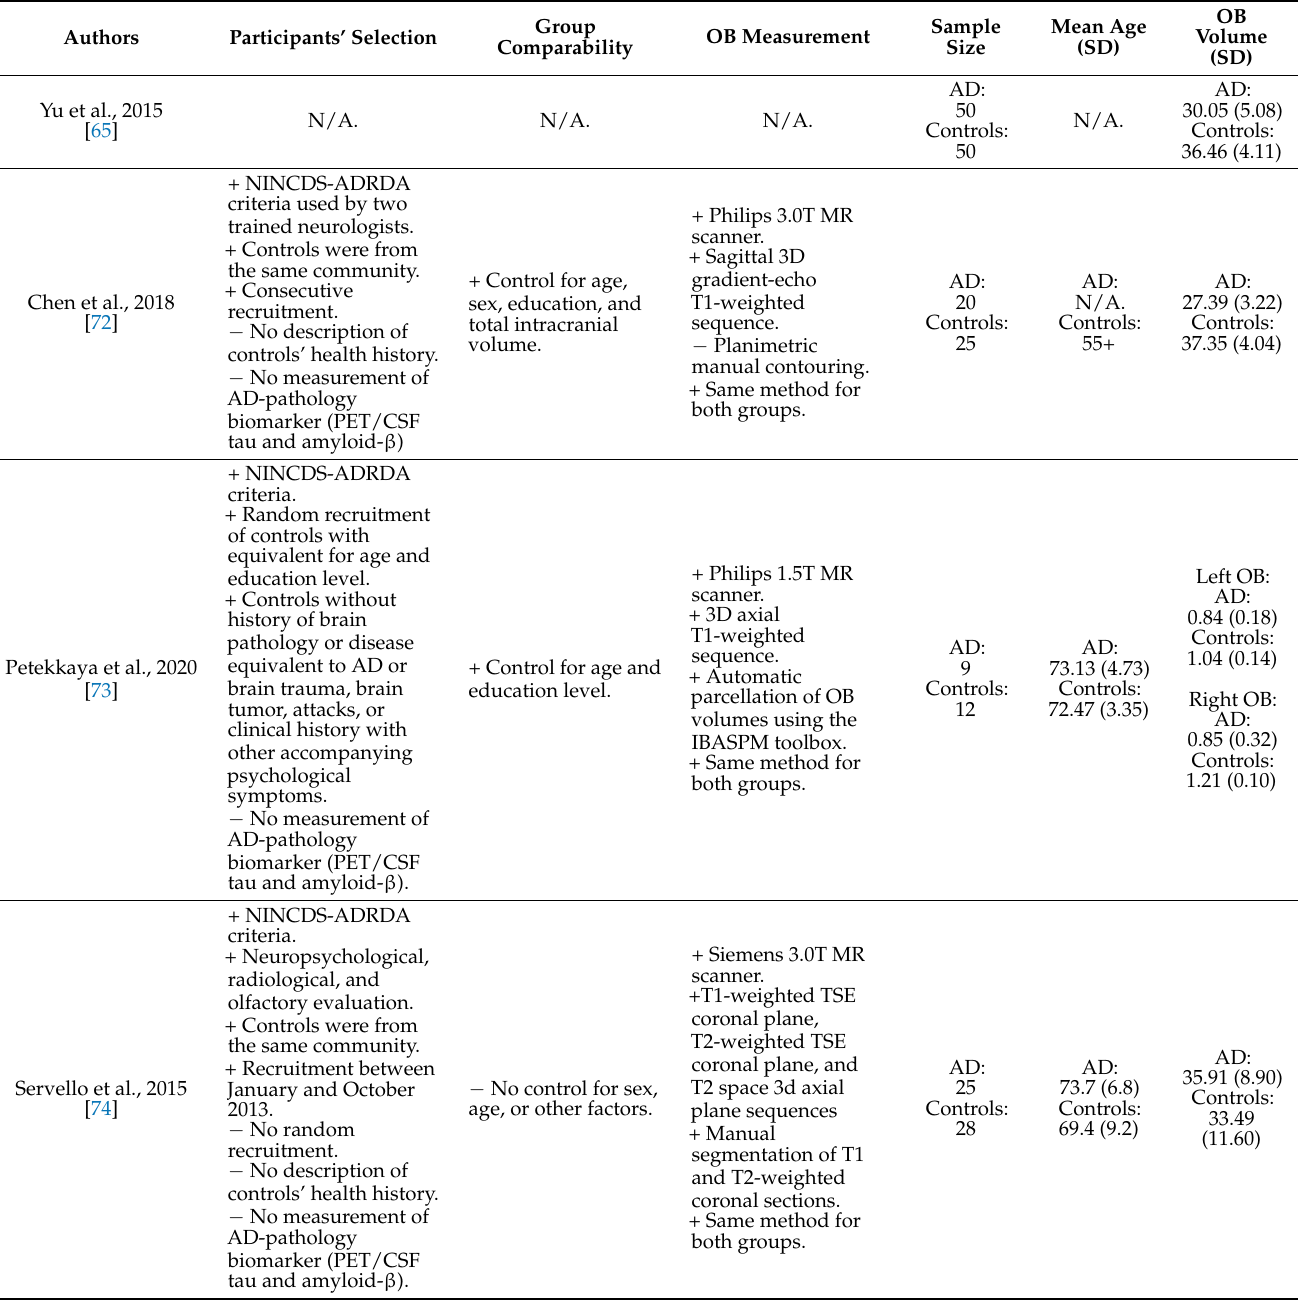
Table 1. Characteristics of studies including patients with AD in the meta-analysis on